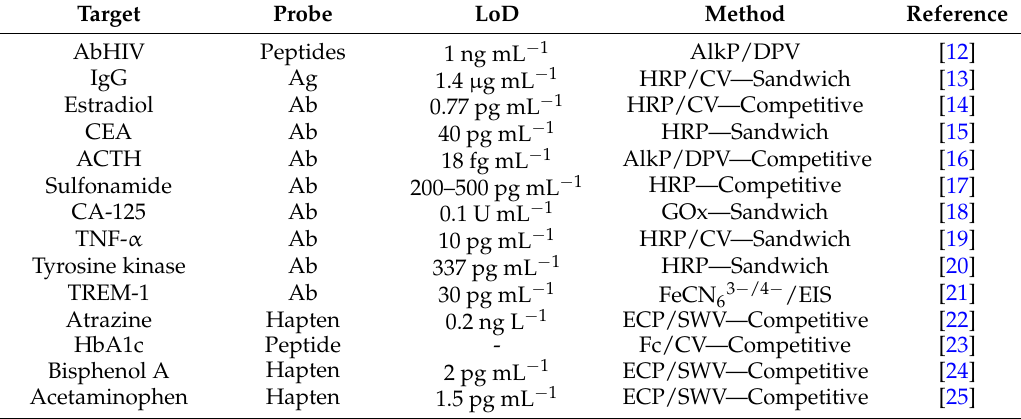
Table 2. Figures of merit of enzyme-based and enzyme-free immunosensors using conventional electrode substrates.